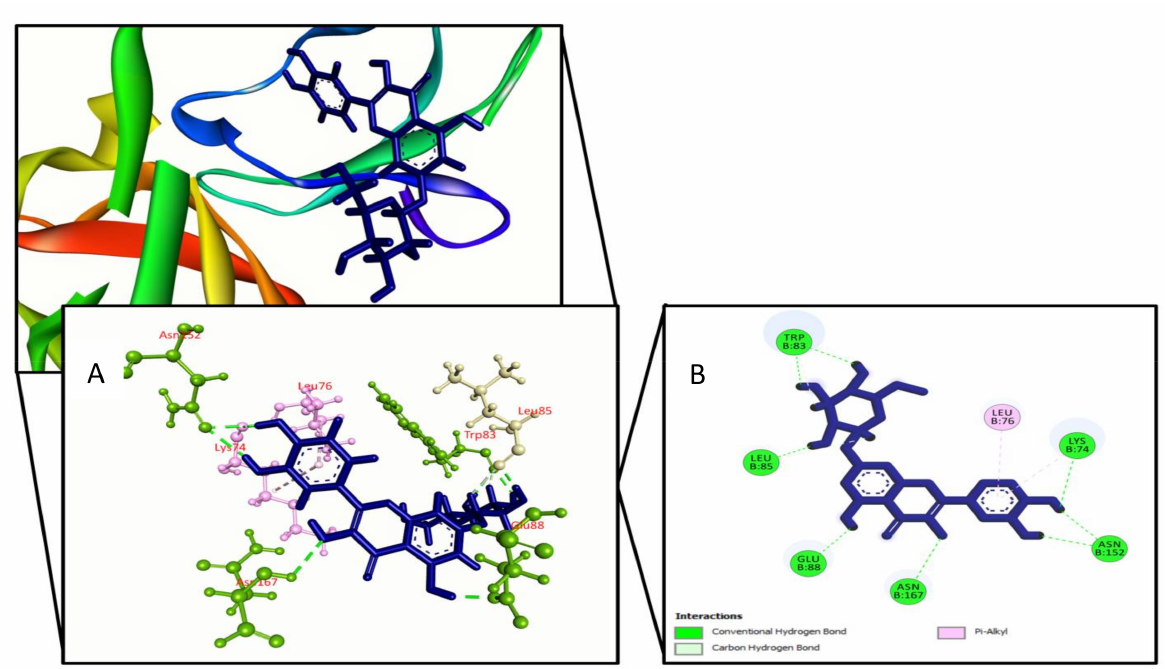
Figure 1. Quercimeritrin binding the Dengue virus NS2B/NS3 protease (PDB: 2FOM), ( A ) 3D representation and ( B ) 2D representation. Hydrogen bonds are displayed as green ball and stick, hydrophobic bonds (Pi–alkyl/alkyl interactions) are displayed as light pink ball and stick, carbon– hydrogen bonds are displayed as white ball and stick.